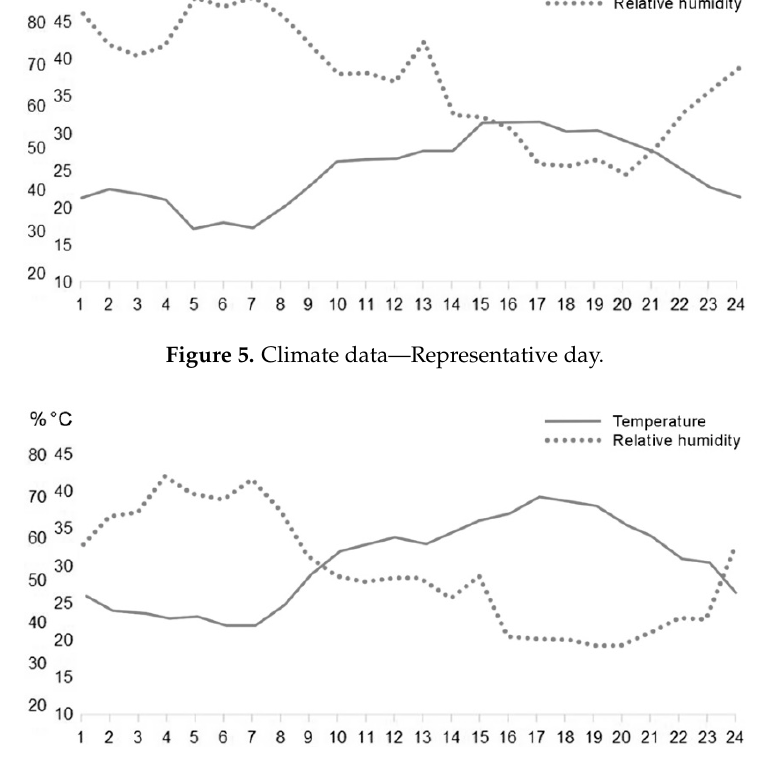
Figure 6. Climate data—Hottest day.